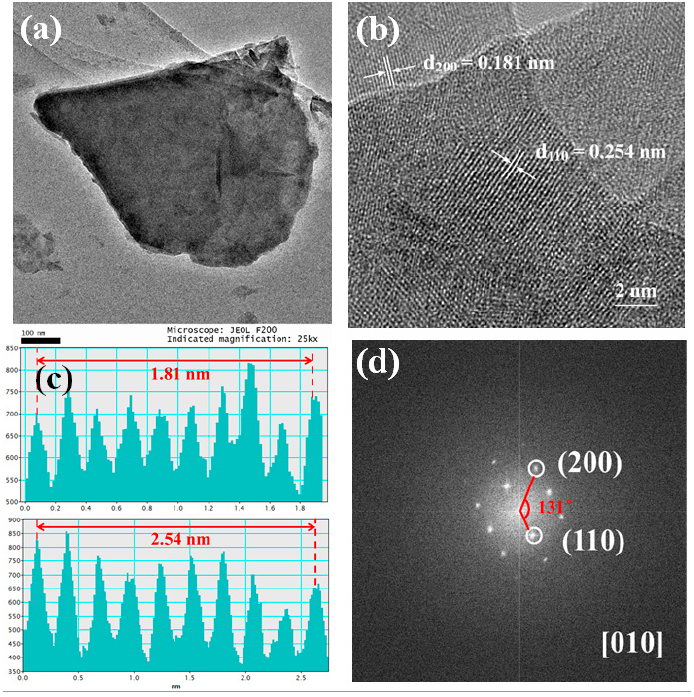
Figure 2. ( a ) HR-TEM figure of the SFC10 sample; ( b ) lattice fringes of the magnified HR-TEM image; ( c ) intensity distribution figures of crystalline fringes matching to ( b ); ( d ) FFT pattern of the SFC10 sample.